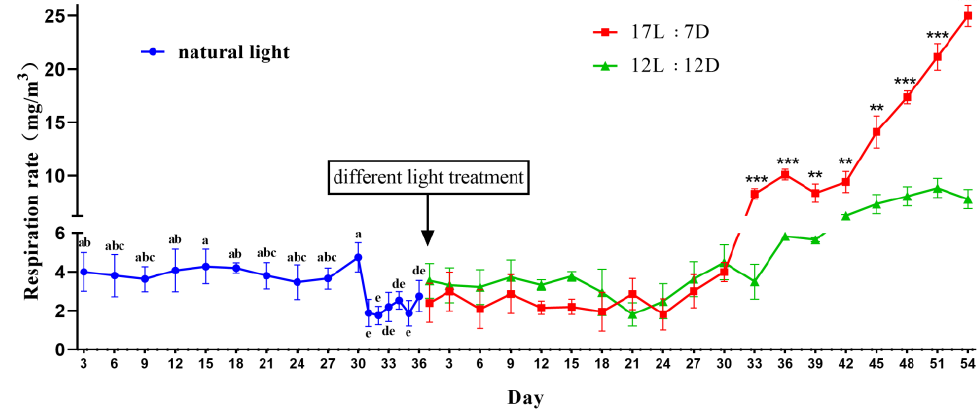
Figure 3. Respiratory metabolism from pupation to diapause, and eclosion under a long photoperiod (17 h L:7 h D) compared with that under a short photoperiod (12 h L:12 h D; control). Data are means ± SD. The significant differences under natural light period were determined using Duncan’s multiple range tests. Different letters above bars show significant difference ( p < 0.05). Under two photoperiod treatment, significant differences was determined using Student’s t -test (** p < 0.01; *** p <